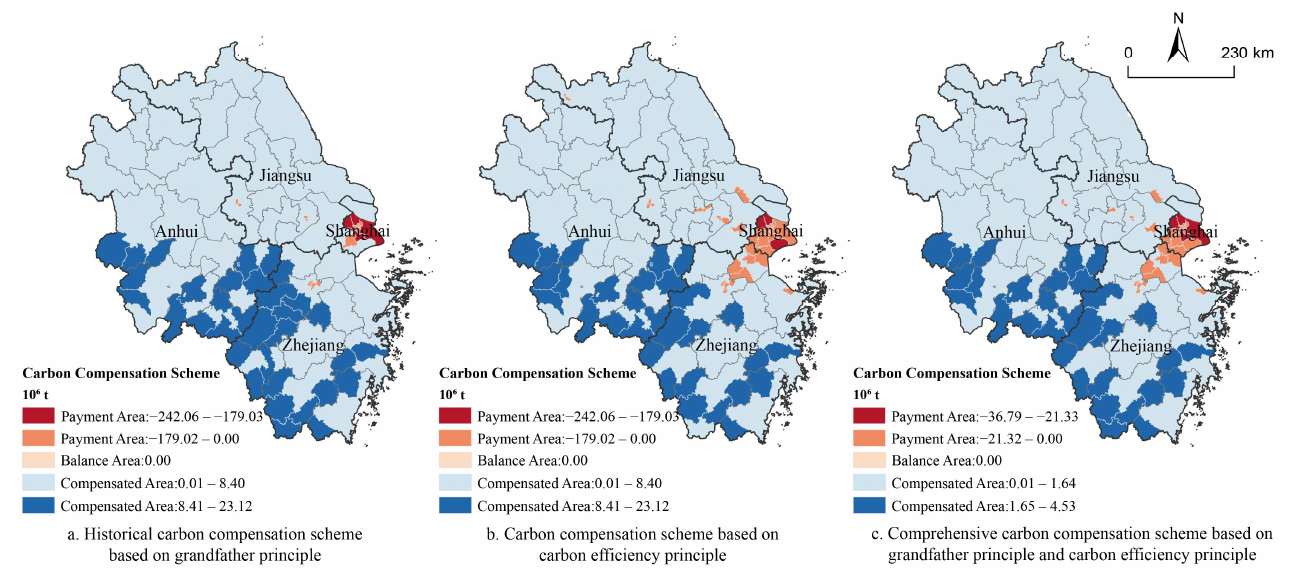
Figure 10. Carbon compensation scheme under different principles.